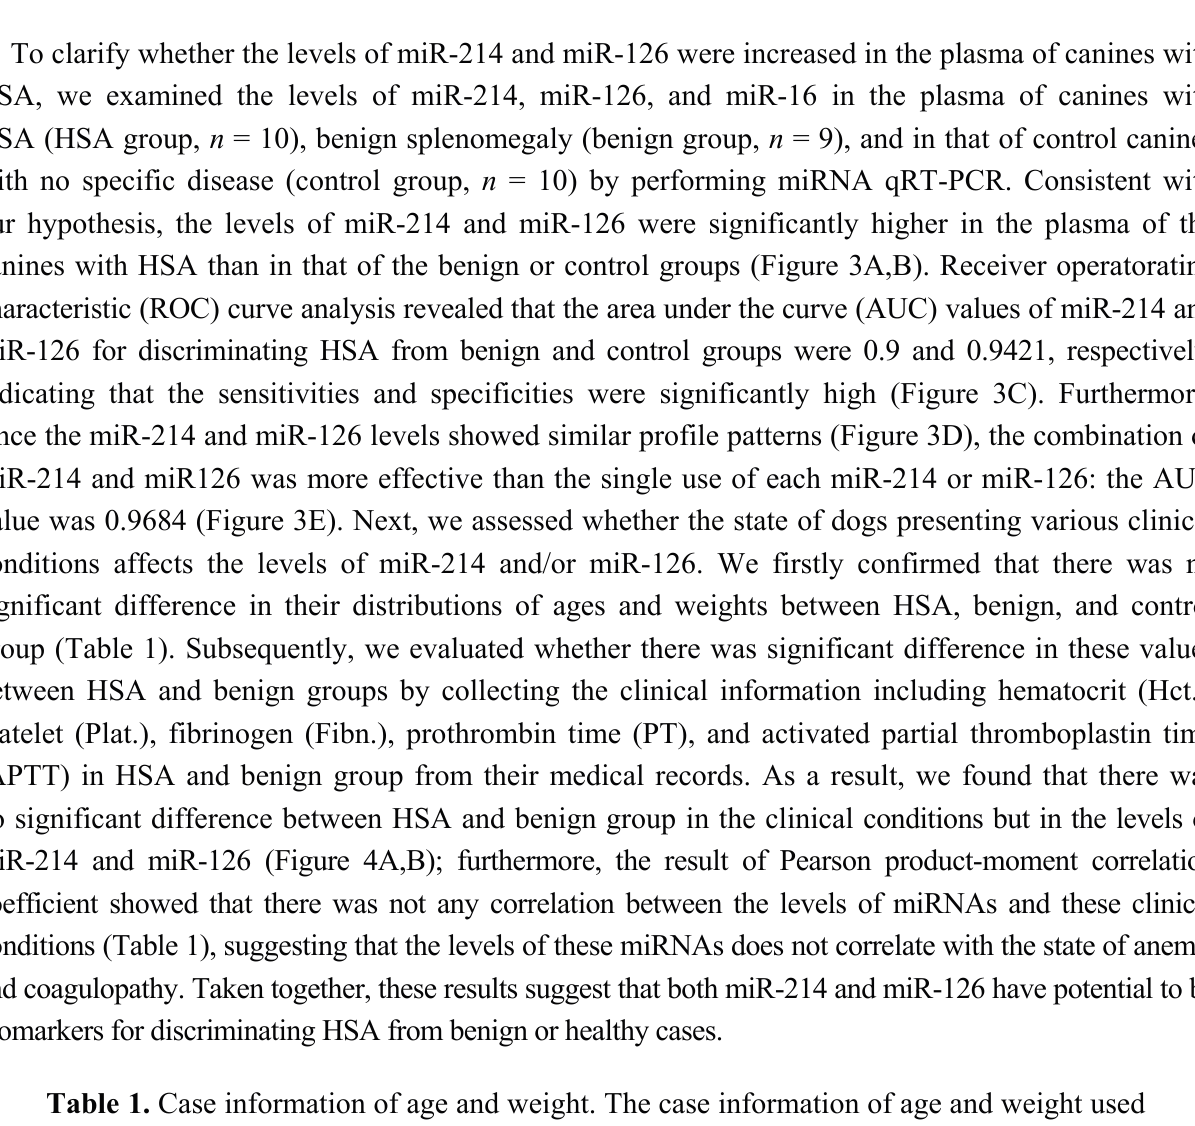
Table 1. Case information of age and weight. The case information of age and weight